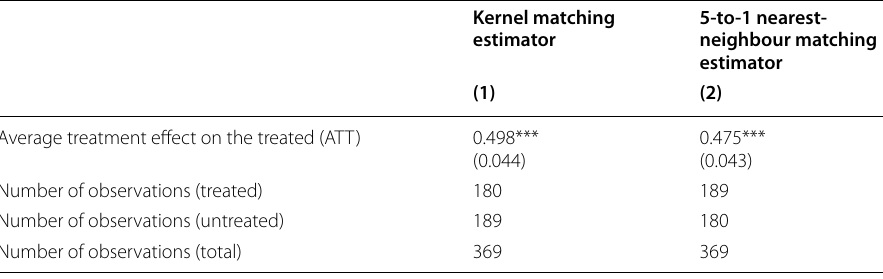
Numbers in parentheses are standard errors